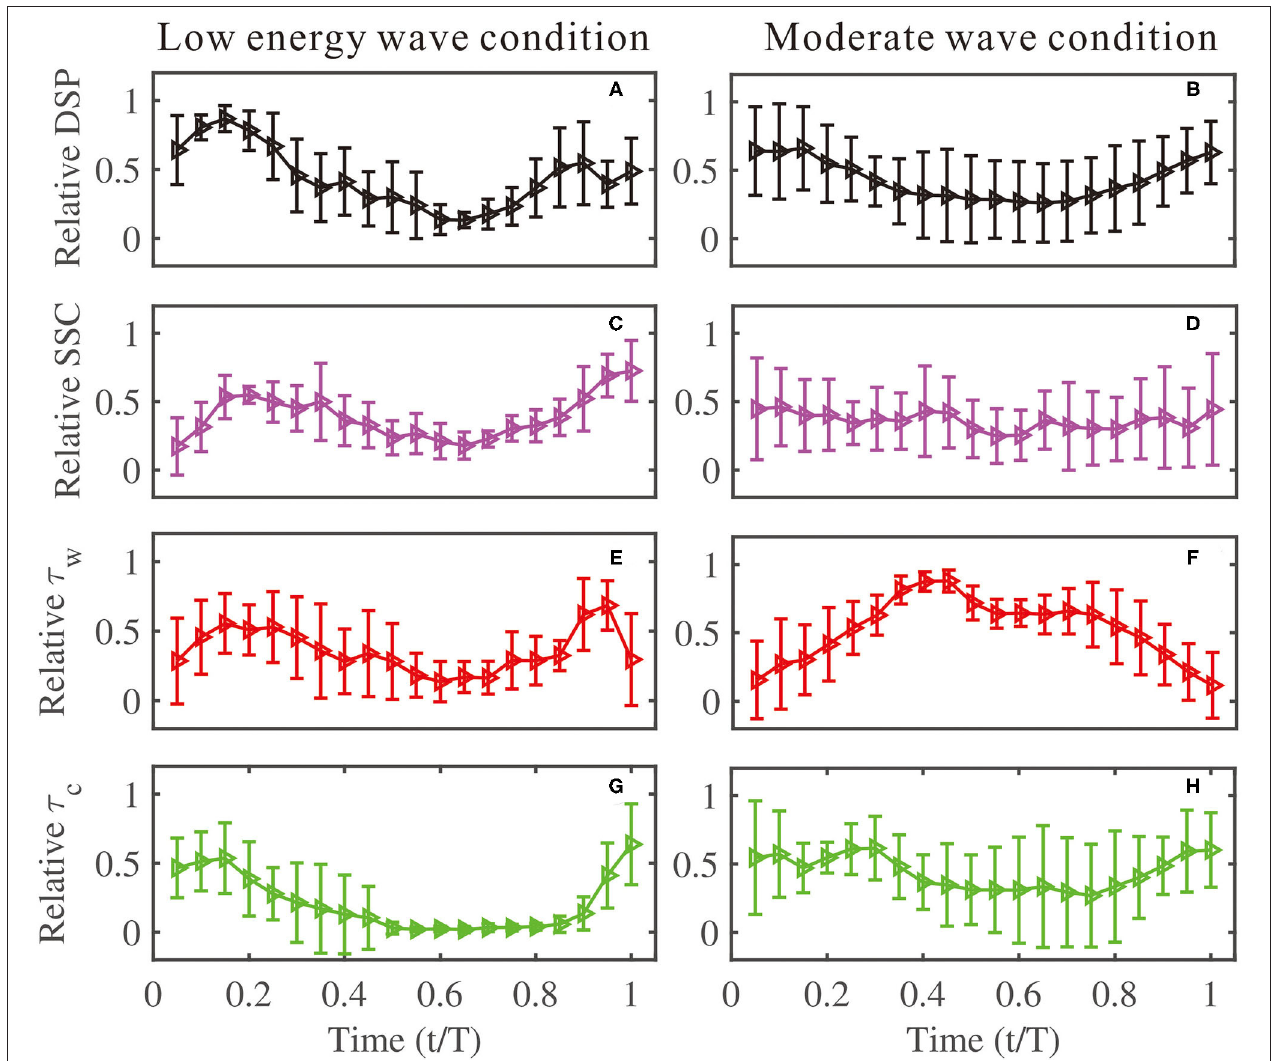
FIGURE 9 | Normalized time series of the DSP (relative DSP, black lines), SSC (relative SSC, magenta lines), bed shear stress induced by wave (relative τ w , red lines), and bed shear stress induced by current (relative τ c , green lines) against normalized tidal cycle (t/T) under (A,C,E,G) low-energy and (B,D,F,H) moderate wave conditions, respectively. The vertical segments indicated ± one